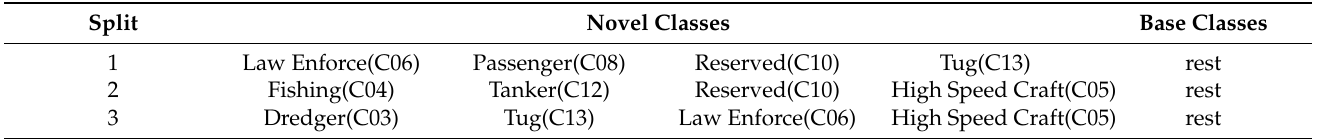
Table 2. Three different base/novel classes split settings in our experiments. Split Novel Classes Base